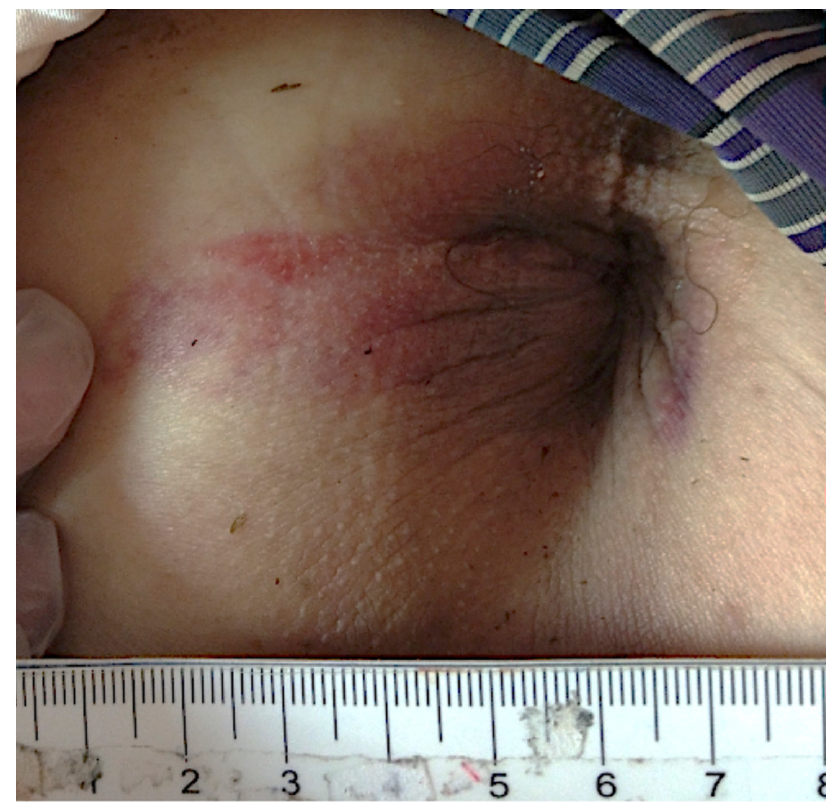
Figure 1. One wound was found at lateral perianal area of the patient.